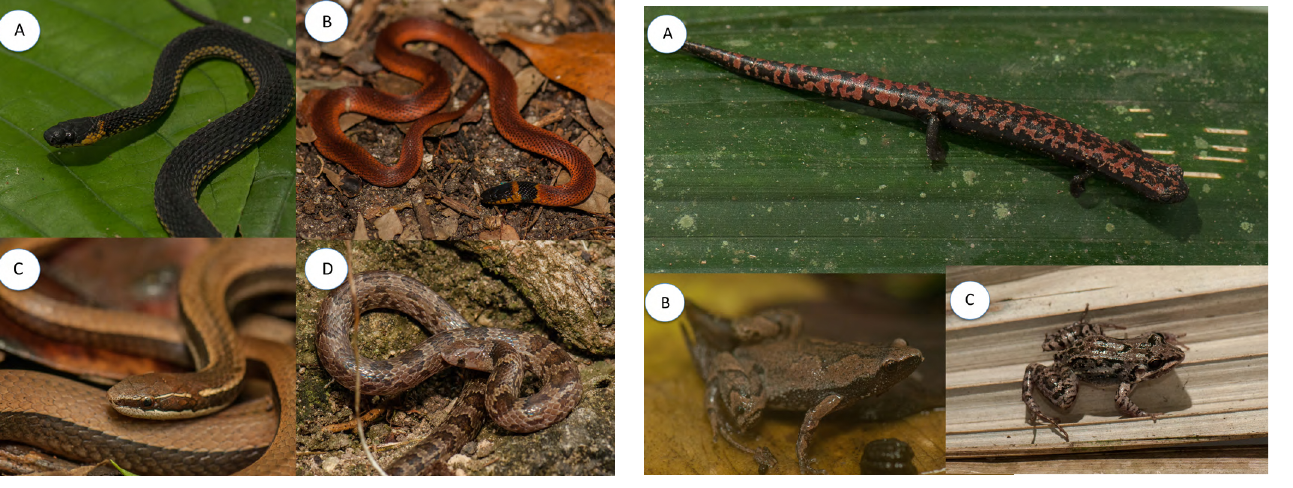
Figure 3. Snakes encountered in the Calakmul Biosphere Reserve: ( A ) Ninia diadema , ( B ) Ninia sebae , ( C ) Coniophanes imperalis , ( D ) Ficimia pub- lia . Photos by TJC.